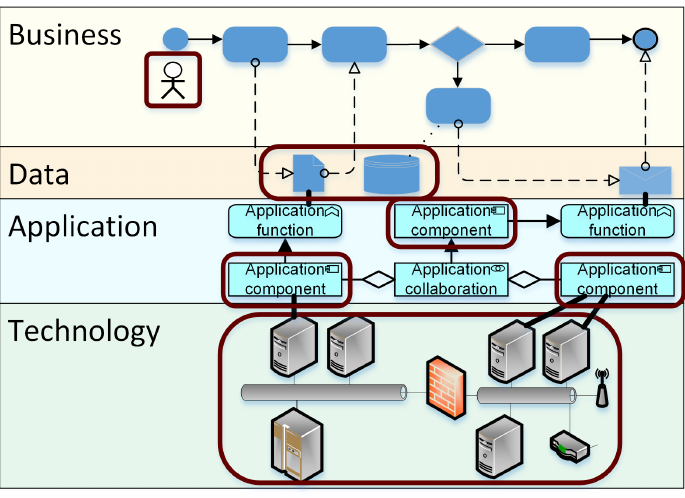
Figure 1. Mainly the technology and partly the application enterprise layers are studied in the article. The studied elements are highlighted with dark red